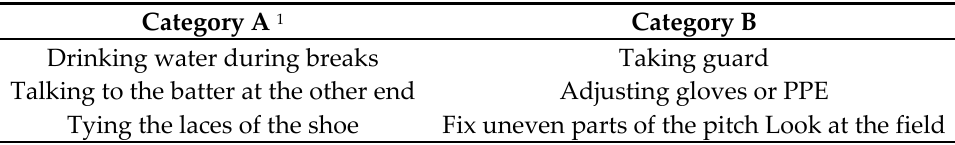
Table 1. Routine activities of a batsman during a cricket batting